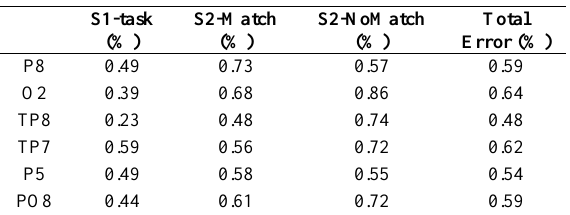
Table 3. Mean HTER for tasks for all individuals of the single-channel system.